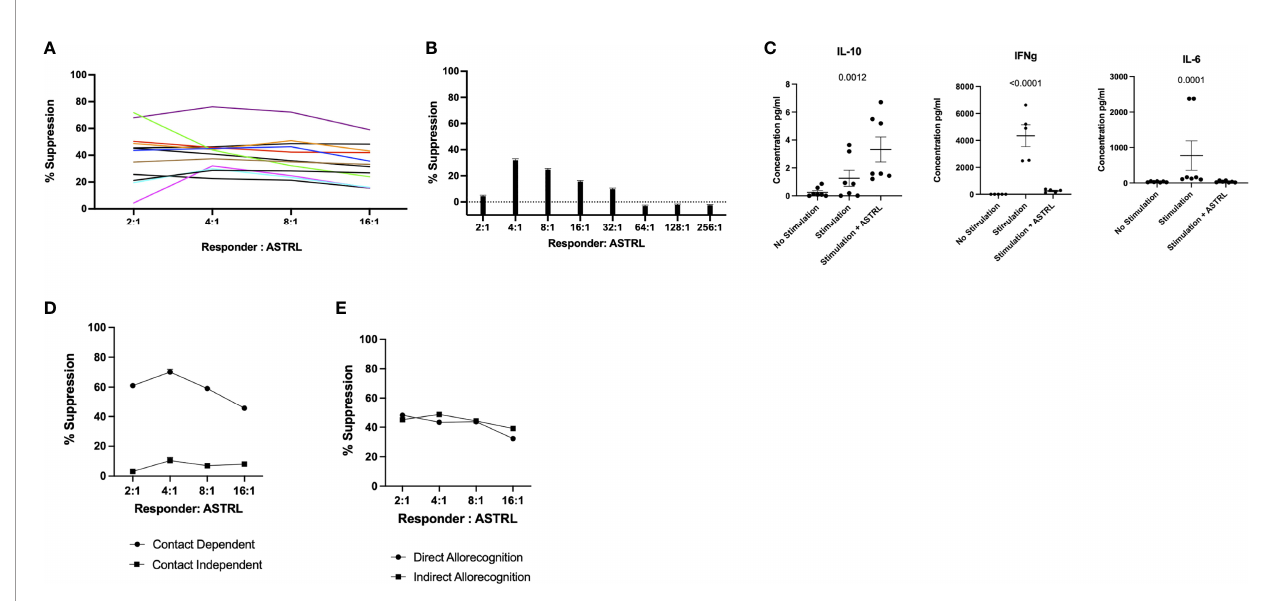
FIGURE 3 | Functional Characterization of ASTRLS. ASTRLs suppress donor antigen speci fi c proliferation of T effector cells. (A) ASTRLs expanded from various KTRs suppress donor antigen speci fi c proliferation of T effector cells. (B) The suppressive effect of ASTRLs on donor antigen speci fi c proliferation increasing ASTRL : Responder ratio. (C) Cytokine production in the culture supernatant of suppression assay by Luminex. (D) Suppressive ability of ASTRL in contact dependent and contact independent transwell assay. (E) Suppressive effect of ASTRL to responder cell proliferation in response to a direct allorecognition using donor cells as stimulators and an indirect allorecognition using autologous irradiated stimulators loaded with donor